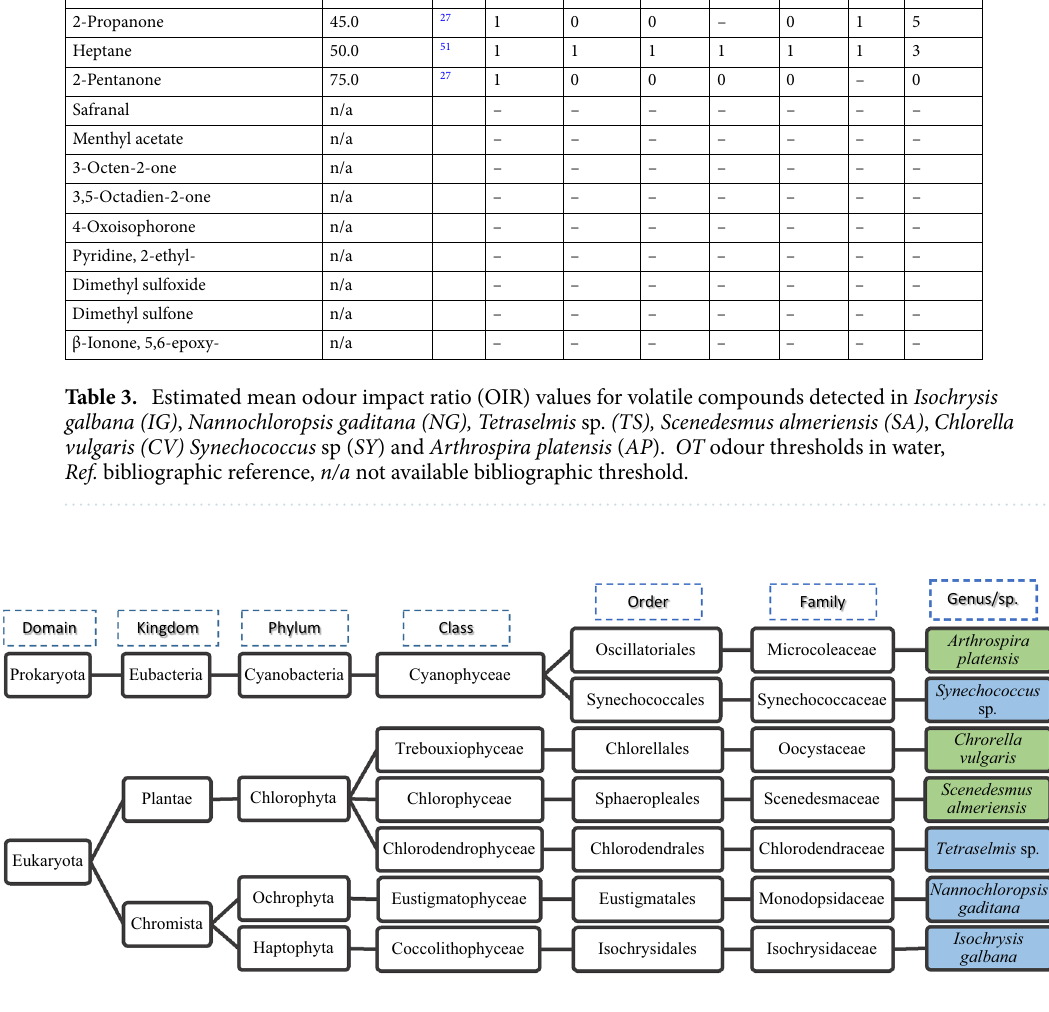
Figure 1. Taxonomic classification of studied microalgal and cyanobacterial strains. Specie/Gender in green are related with freshwater while those in blue are representative of marine